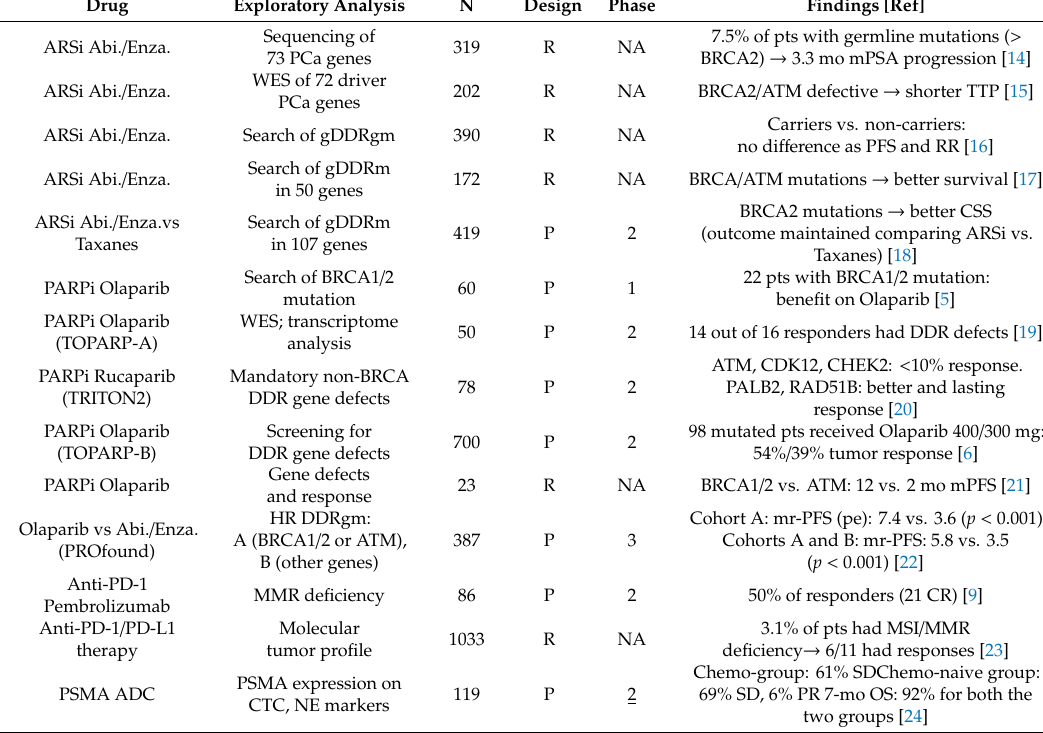
Table 1. Published clinical studies in metastatic castration-resistant prostate cancer (mCRPC) patients exploring the correlation between DNA damage repair (DDR) pathways and single-agent therapies with androgen receptor-signaling inhibitors (ARSi), poly (adenosine diphosphate [ADP]-ribose) polymerase inhibitor (PARPi), immune checkpoint inhibitors (ICI), and prostate-specific membrane antigen inhibitors